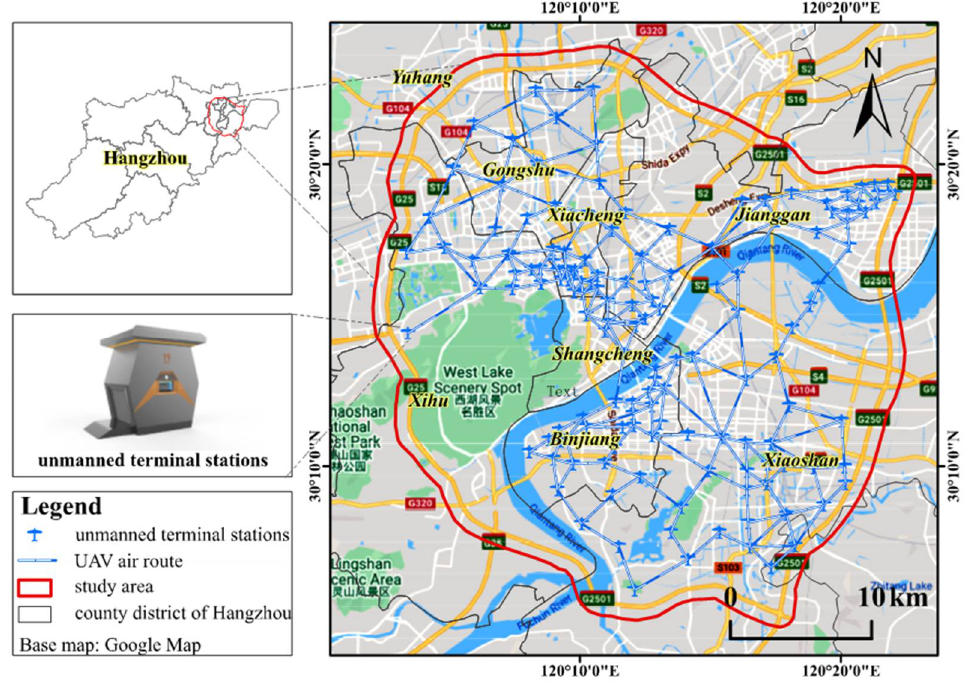
Figure 1. The spatial distribution of unmanned aerial vehicles (UAV) logistics network in Hangzhou.